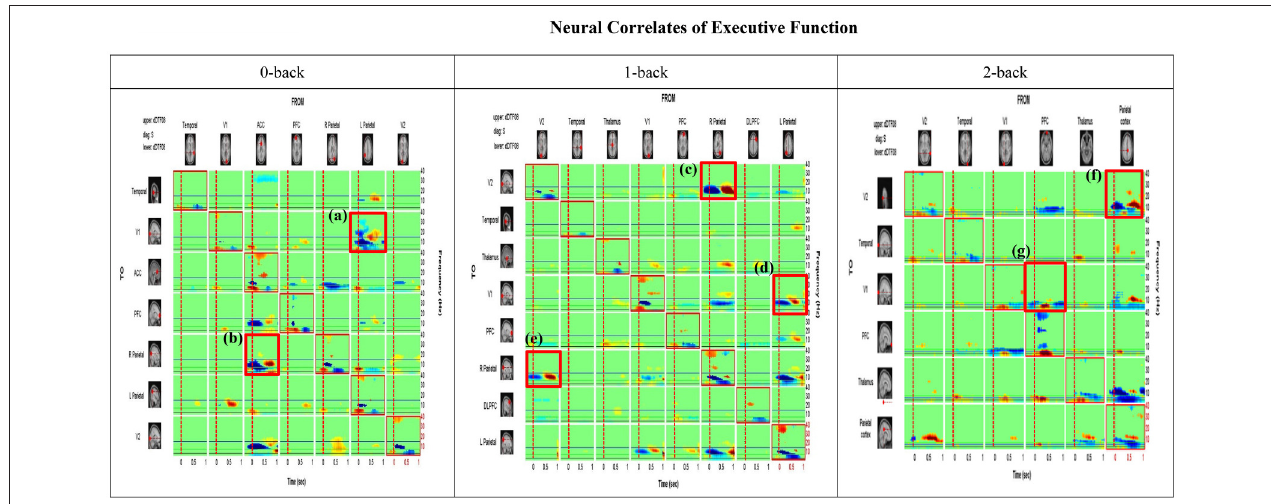
FIGURE 5 | Time-Frequency Grid. Each cell of the matrix shows the time-frequency distribution of information transfer between a respective pair of ICs (i.e., columns represent the source or FROM and rows represent destination or TO), with the highest information transfer indicated by warm colors. The frequency is on the y-axis and time on the x-axis on each cell of the matrix. The upper and lower triangles of the grid (i.e., above and below the red-bordered diagonal cells, respectively) : : represent the dDTF (conditional GC) between each pair of sources (e.g., Visual cortex 2 Visual cortex 1; Prefrontal cortex V2). Under the 0 back condition, the area (a) boxed in red [row 2, col 6] shows information flows at different times and frequencies from the source column 6 (Parietal) to the source row 2 (V1). The area (b) [row 5, col3] exhibits casual flow from the source column 3 (ACC) to the source row 5 (Parietal). On the other hand, under the 1 back condition, two boxed area (c) and (e) show bi-directional causal flows between V2 and right parietal cortex. The boxed area (d) indicates flows from the source column 8 (Left Parietal) to the source row 4 (V1). Lastly, under the 2 back condition, the boxed area (f) shows causal flows from the source column 6 (Parietal cortex) to the source row 1 (V2). The boxed area (g) presents information flows from the source column 4 (PFC) to the source row 3 (V1). The anatomical dipole locations for each source are rendered on the